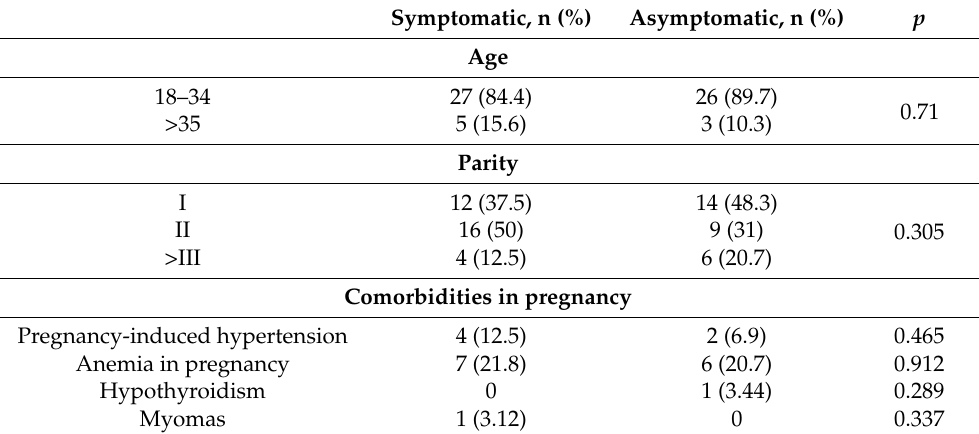
Table 1. Maternal characteristics in pregnant women with SARS-CoV-2